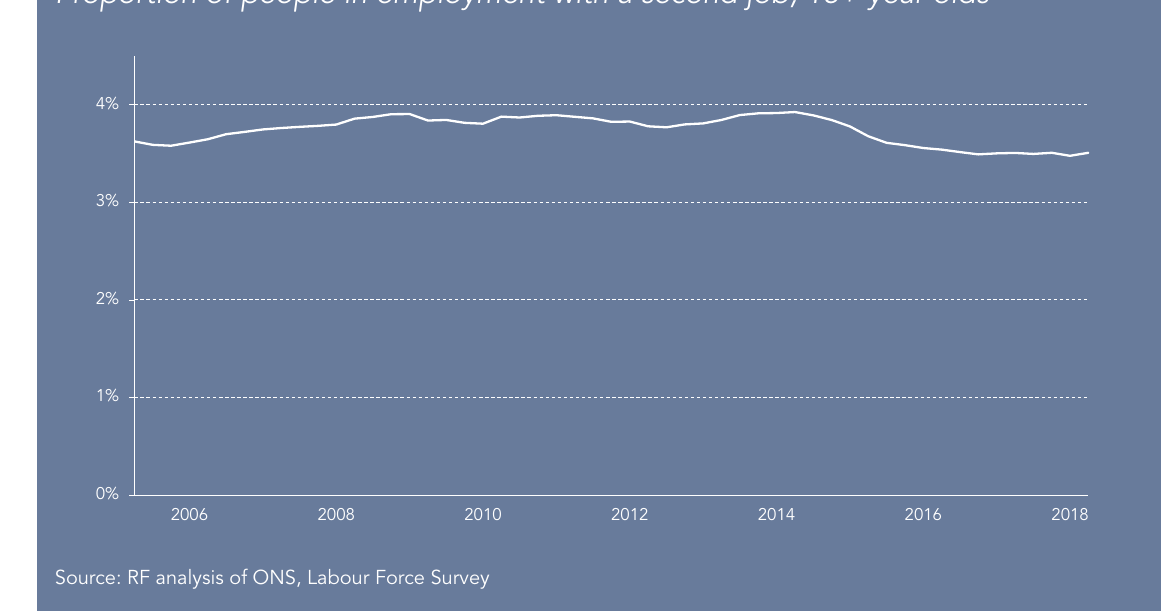
Source: RF analysis of ONS, Labour Force